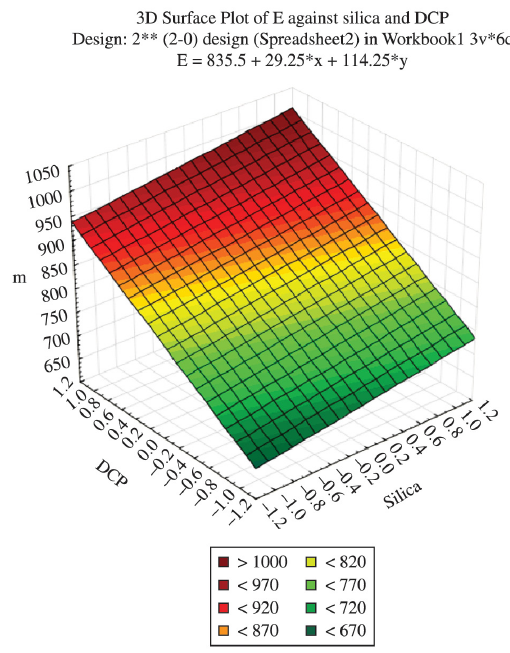
Figure 6. Surface Graph of the composite with silica in the experimental design for E’. Where X= silica content, Y= DCP content and E= modulus.